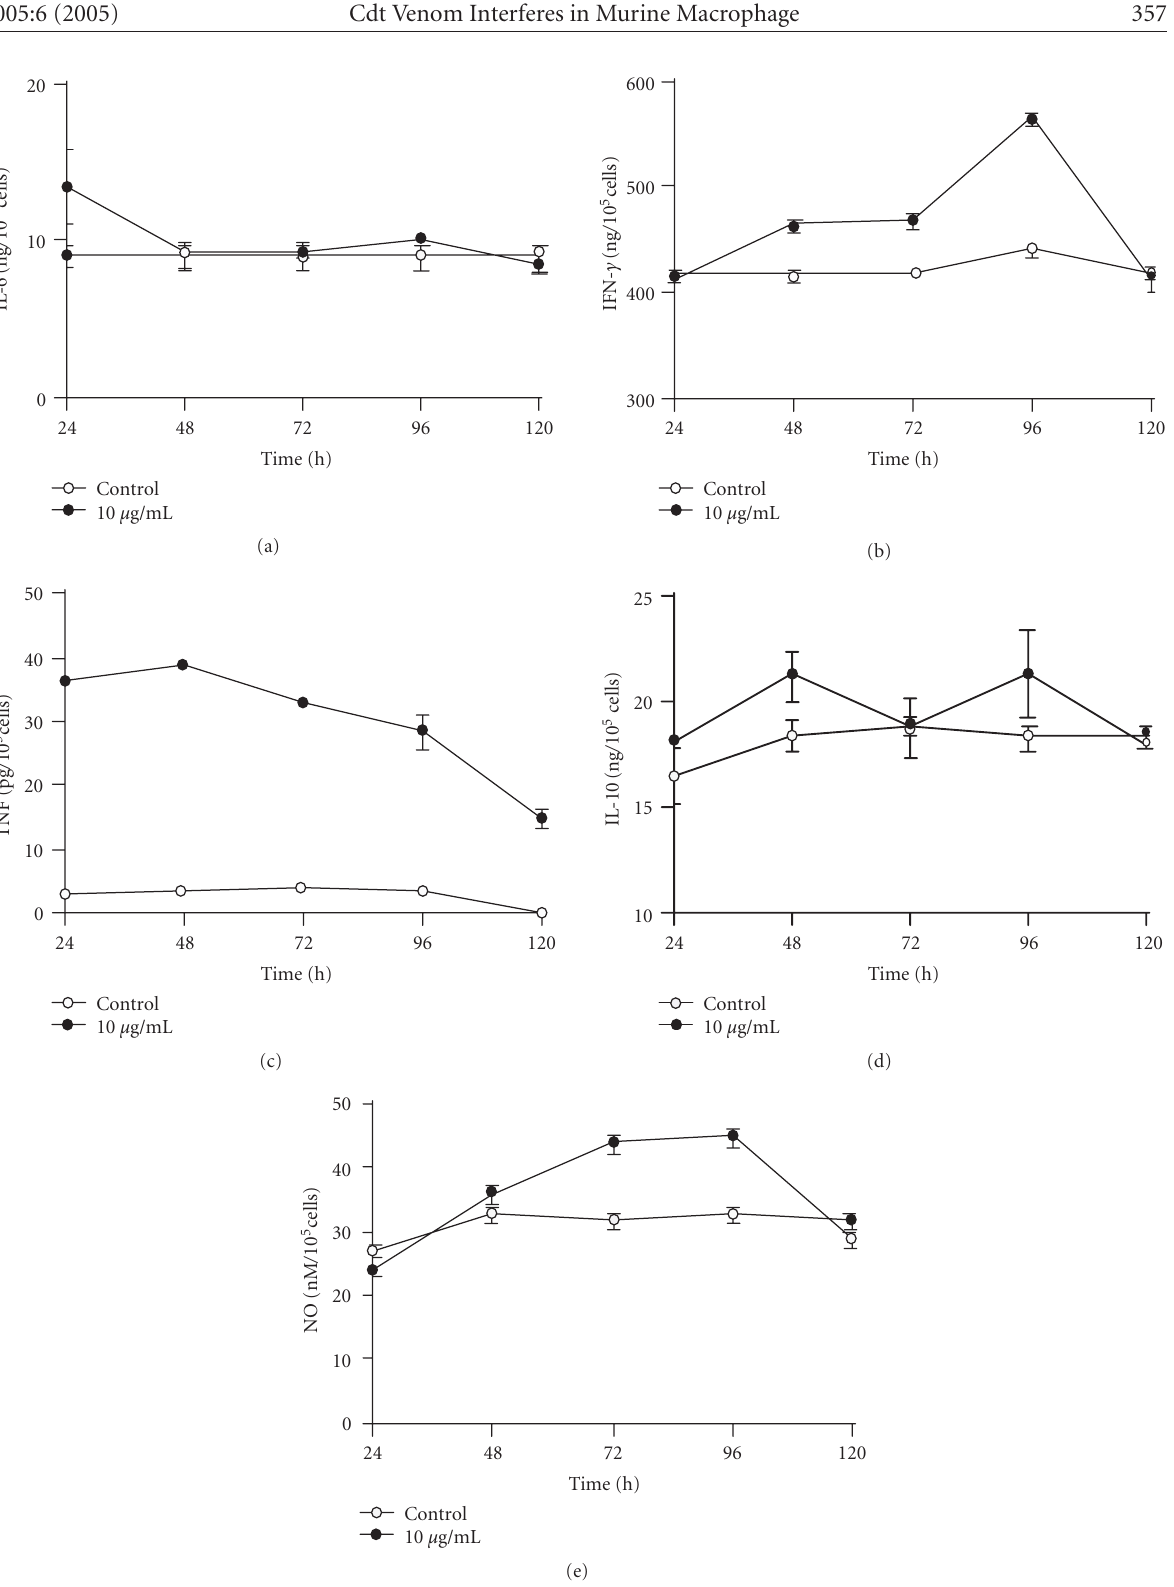
Figure 5. Cytokines released by peritoneal macrophages from BALB/c mice. Peritoneal macrophages were obtained and exposed in vitro to 10 µ g/mL of Cdt for di ff erent periods of time as described in “materials and methods.” IL-6, IL-10, and IFN- γ were assayed by ELISA using monoclonal antibodies as the probe. TNF levels were determined by standard assay with L929 cells. NO levels were detected by the Griess colorimetric reaction. Each point represents the mean value of samples from five experiments in di ff erent groups of five mice. Statistical di ff erences between the treatments were P > .